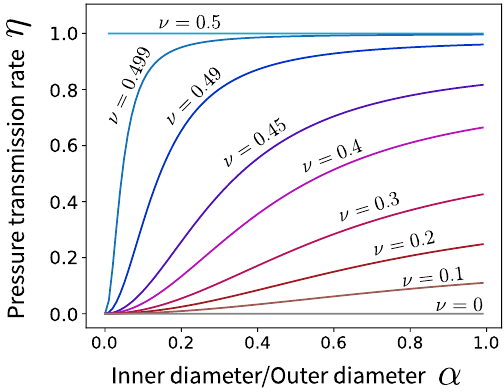
Figure 5. Relationship between α and η